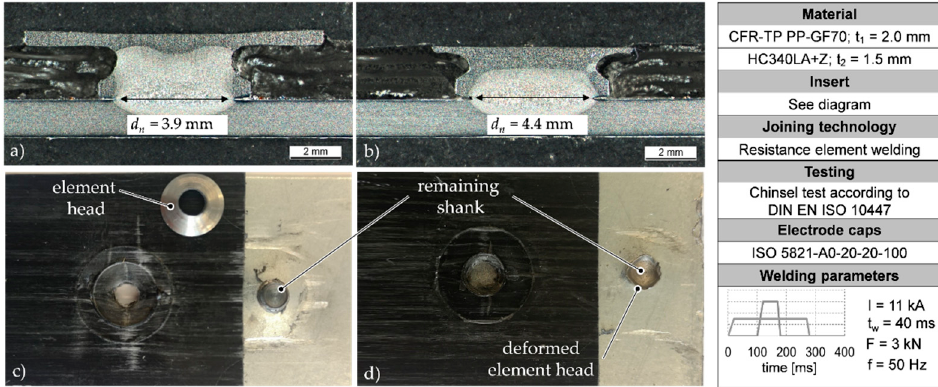
Figure 10. Analysis of the joining zone after resistance element welding (REW) (top: micrographs of welded joints using weld insert type A ( a ), and type B ( b ), bottom: pictures of welded specimen using weld insert type A ( c ) and type B ( d ) after chisel tests).